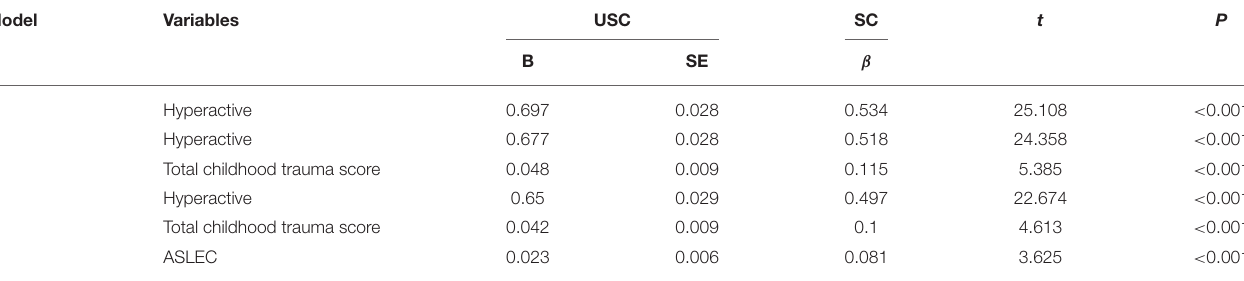
TABLE 3B | Linear regression analysis for hyperactivity, severity of childhood trauma, and life events predicting somatic complaints.